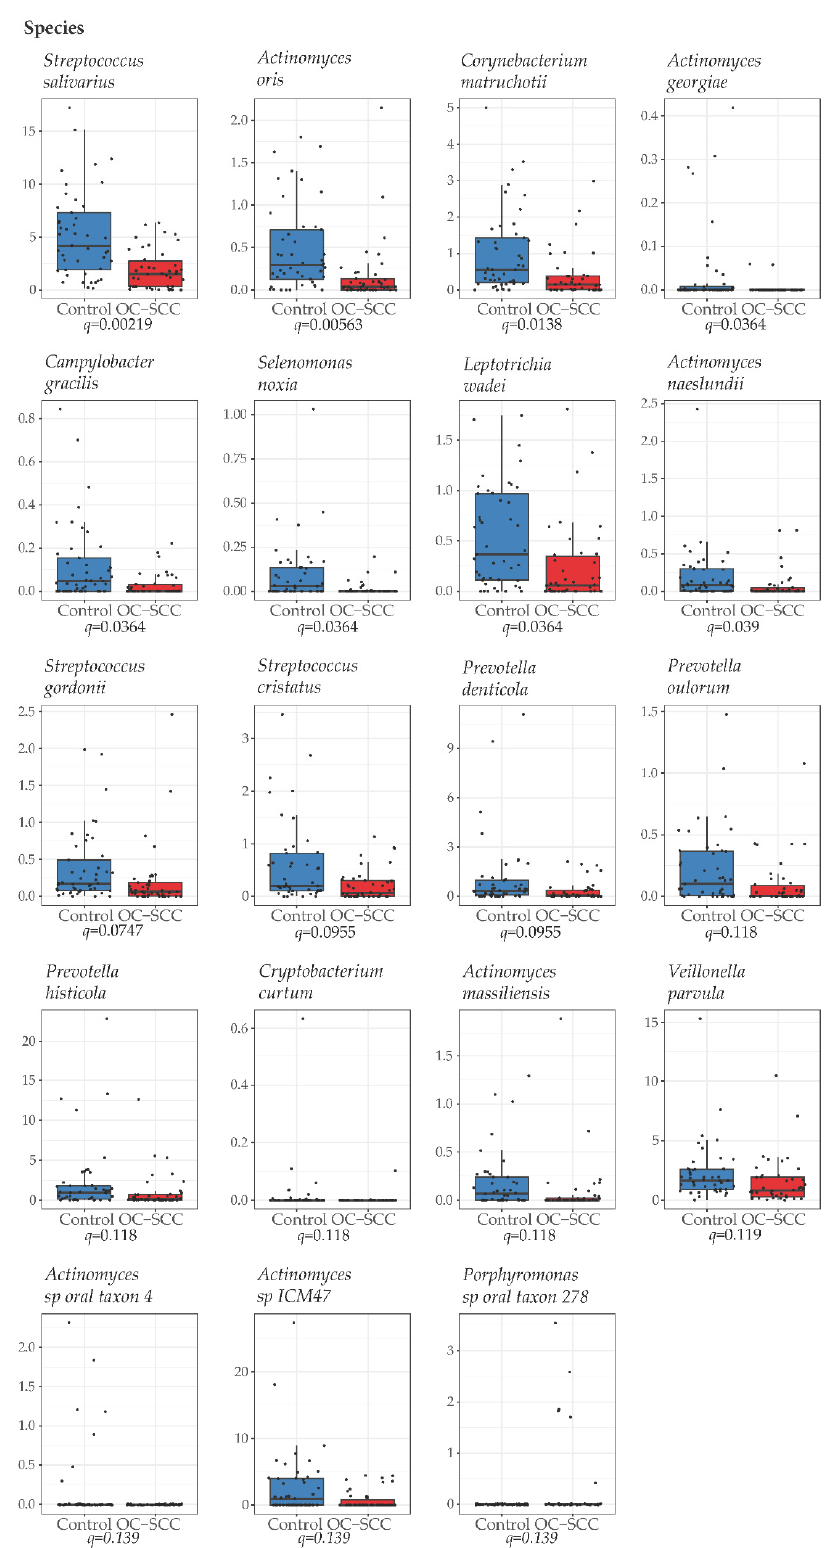
Figure 3. Differential bacterial species between nonsmoking OC-SCC patients and non-OC-SCC control patients. The Y -axis shows relative abundance in percentage. The difference in the relative abundance of species was evaluated by the Mann–Whitney test and a false discovery rate–adjusted p value ( q value) <0.20 was used as the threshold for significance.